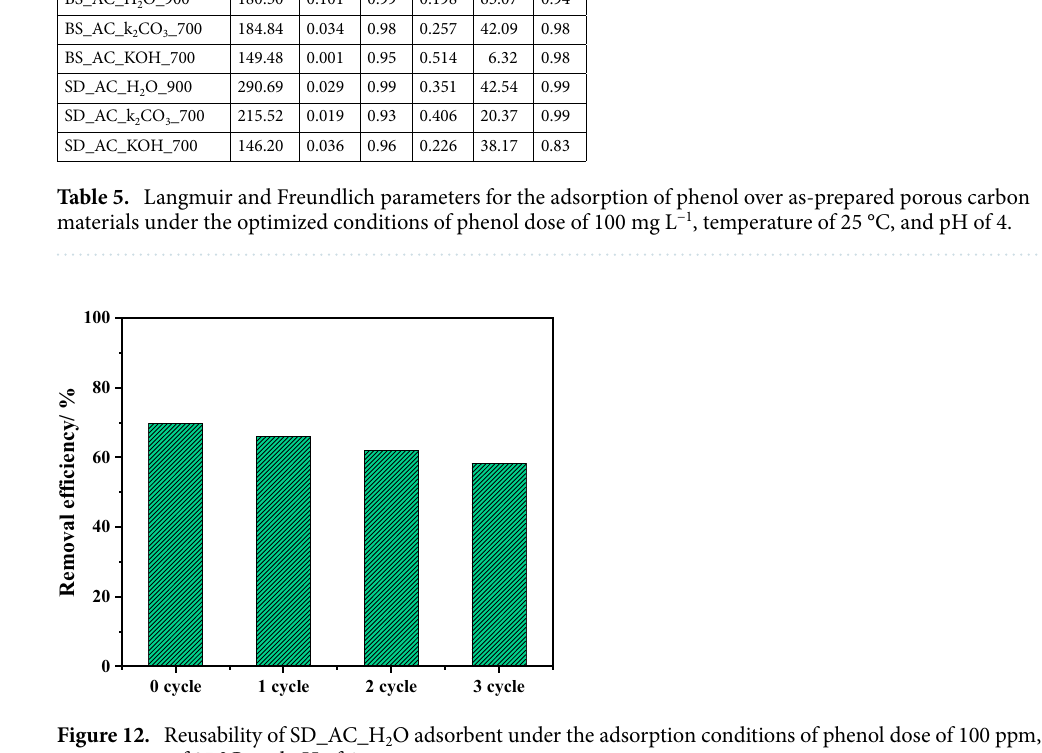
Figure 12. Reusability of SD_AC_H 2 O adsorbent under the adsorption conditions of phenol dose of 100 ppm, temperature of 25 °C, and pH of